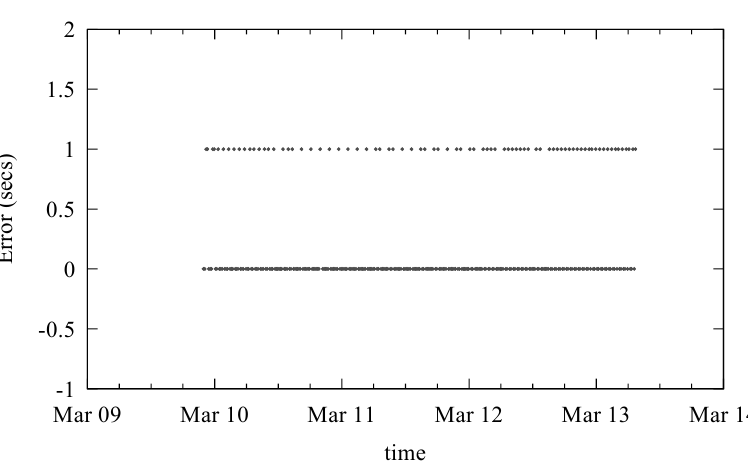
Figure 5. Drift estimate during the experiment.